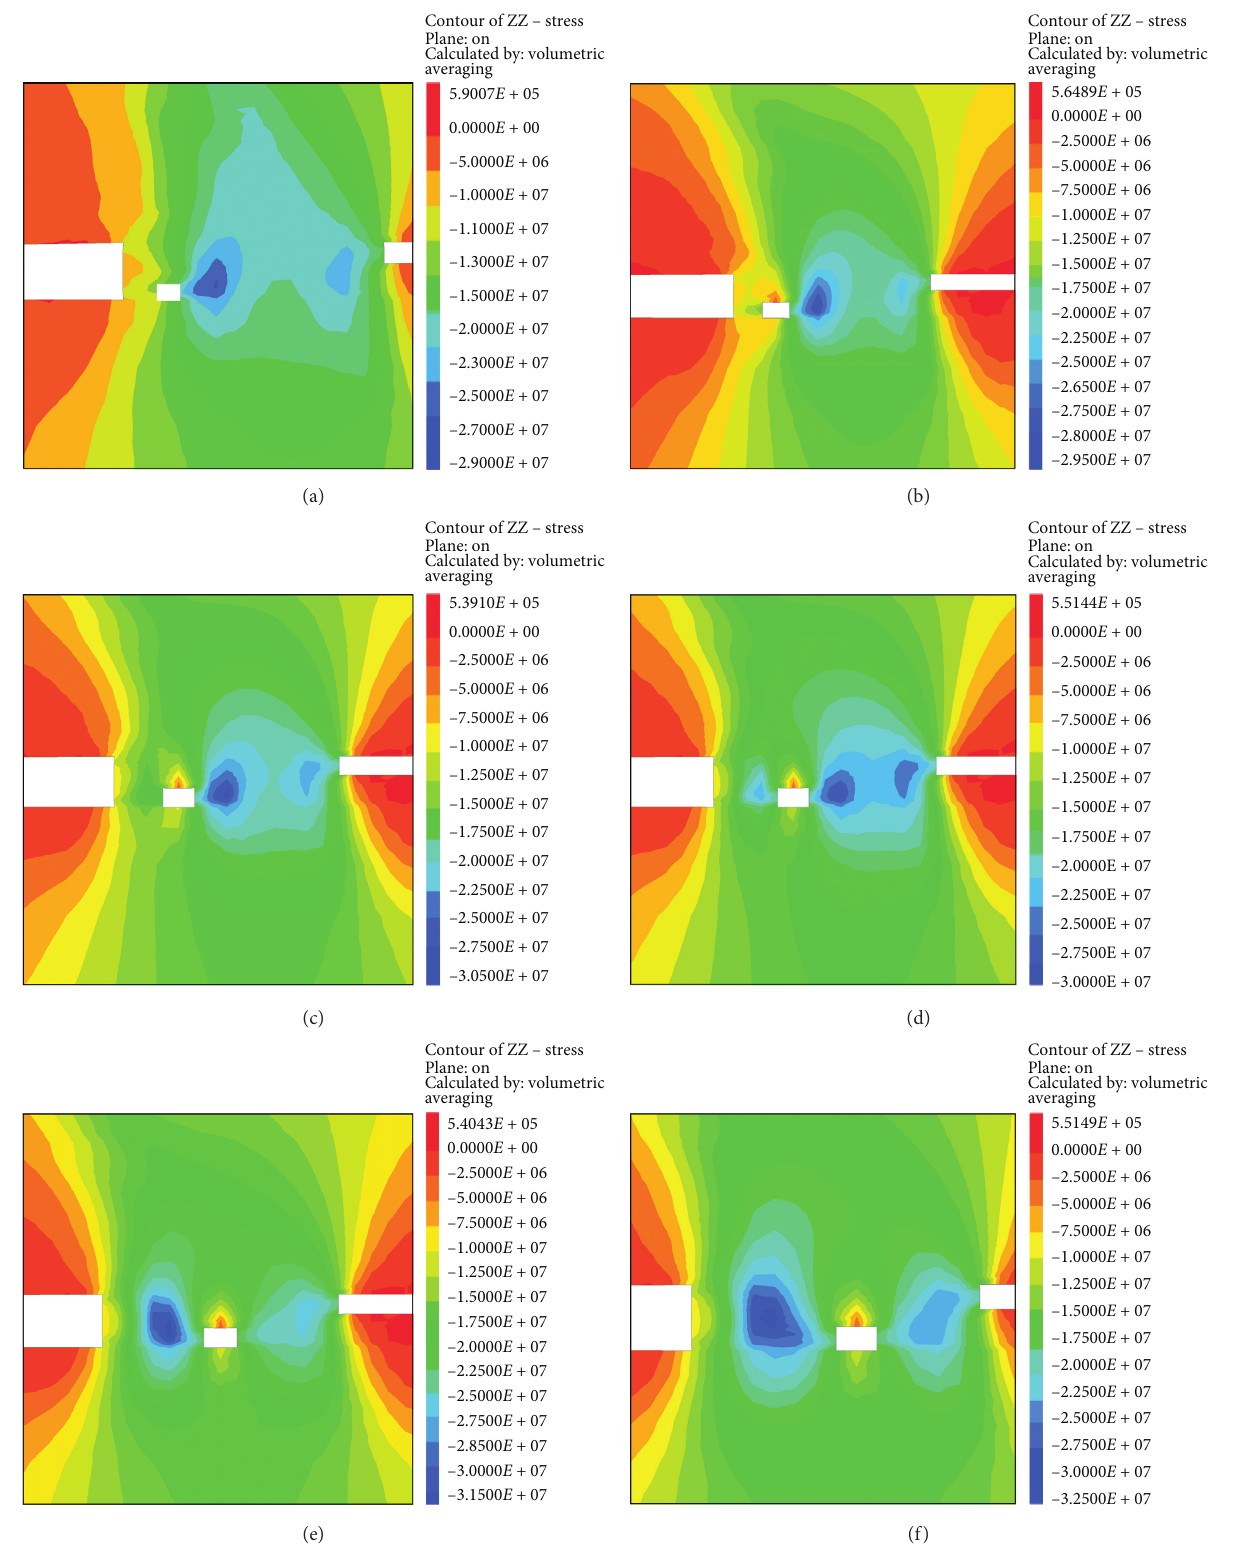
Figure 14: Vertical stress diagram of coal pillars in different width sections: (a) 4m, (b) 5m, (c) 8m, (d) 10m, (e) 13m, and (f)